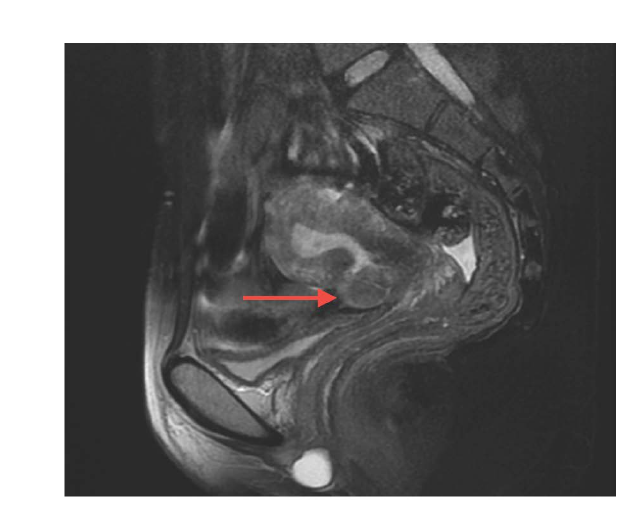
Figure 2. Pelvic Magnetic Resonance Imaging Demonstrating Tu- berculoma in a Uterine Dehiscence. Because of this report, the Infectious Diseases (ID) team was consulted and recommended moving the patient to a negative pres- sure room, performing a chest x-ray (CXR), sending the specimen for M. Tuberculosis PCR testing and performing a TB quantiferon. During interview by the ID team, the patient did admit to a his- tory of a positive TB quantiferon, but stated that her most recent CXR was negative. Of note, she also reported a history of Bacillus Calmette-Guerin (BCG) vaccination as a child. Ultimately, the